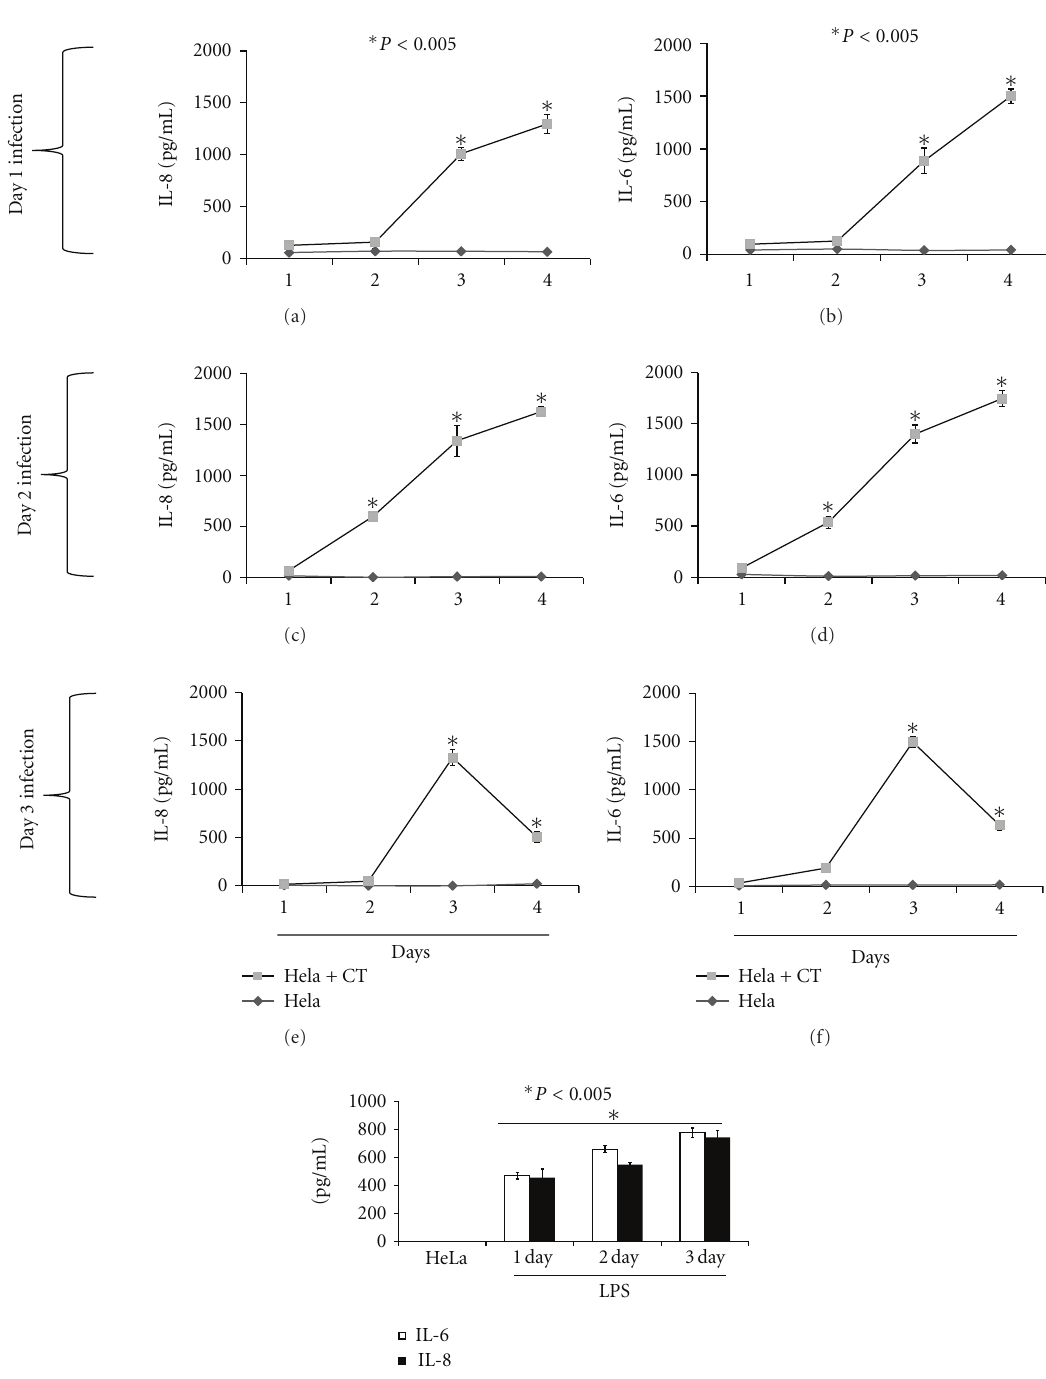
Figure 2: Expression profiles of IL-8 and IL-6 produced in C. trachomatis- (CT-) infected HeLa cells cumulative supernatants . HeLa cells (10 5 cells/mL/well) were seeded in 24-well plates. Twenty-four later cells were infected with C. trachomatis EBs (10 4 IFU/well) and after day 1 (a and b), day 2 (c and d), and day 3 (e and f) infection of cells, supernatants were collected daily without replacing with fresh media (cumulative). Human IL-8 and IL-6 cytokines were measured using cytokine-specific ELISAs. As a positive control HeLa cells (10 6 cell/mL/well) were stimulated with LPS (1 μ g/mL) for various time-points (g). Asterisk indicates significant di ff erence ( P < 0 . 005), and P values were calculated by use of Student’s t- test. Each bar represents the mean ± SD of samples run in triplicates. The data are representative of two separate